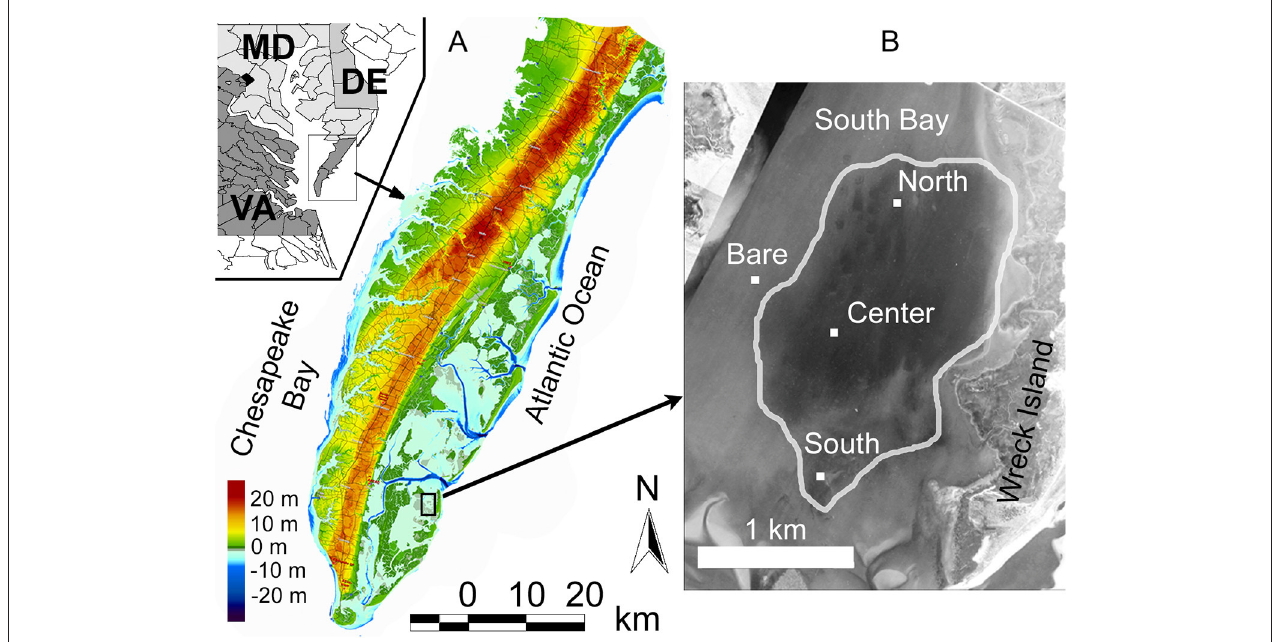
FIGURE 1 | (A) Location of study area off-shore of the Delmarva Peninsula, Virginia. Seagrass study site is in South Bay, indicated in the black box. Color-map shows the land elevation and bathymetry of the Delmarva Peninsula relative to the North American Vertical Datum of 1988 (NAVD88). (B) Site locations within South Bay, superimposed on an aerial photograph modified from Orth et al. (2012). The extent of the seagrass meadow as of 2010 is indicated by the area within the white line.